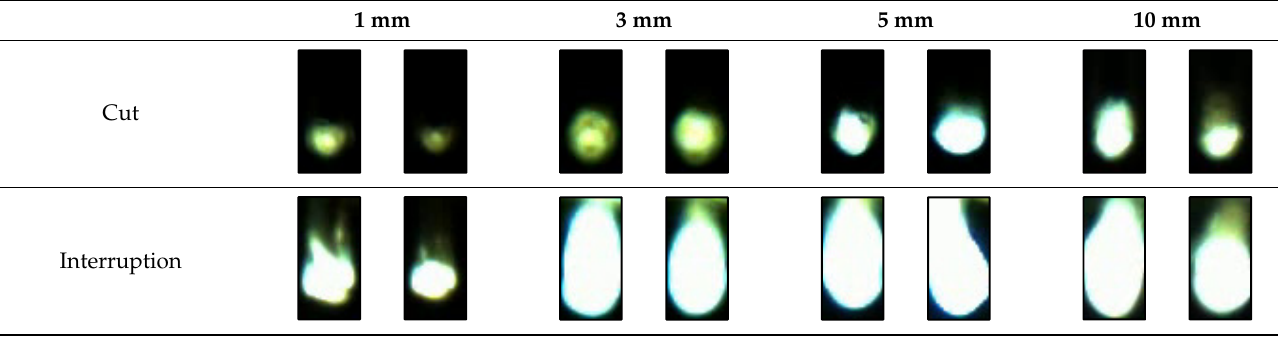
Figure 3. Original camera image.